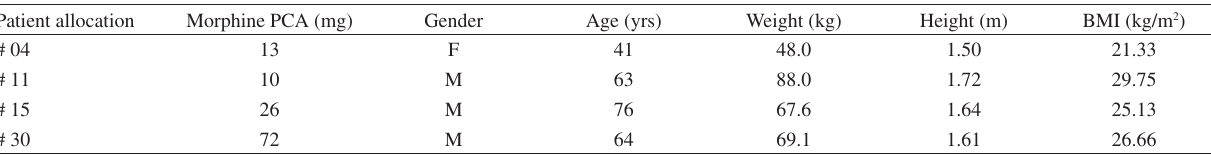
Table 1 - Demographic and somatic characteristics, drug requirements (PCA) and analgesia after extubation in the late postoperative period Patient